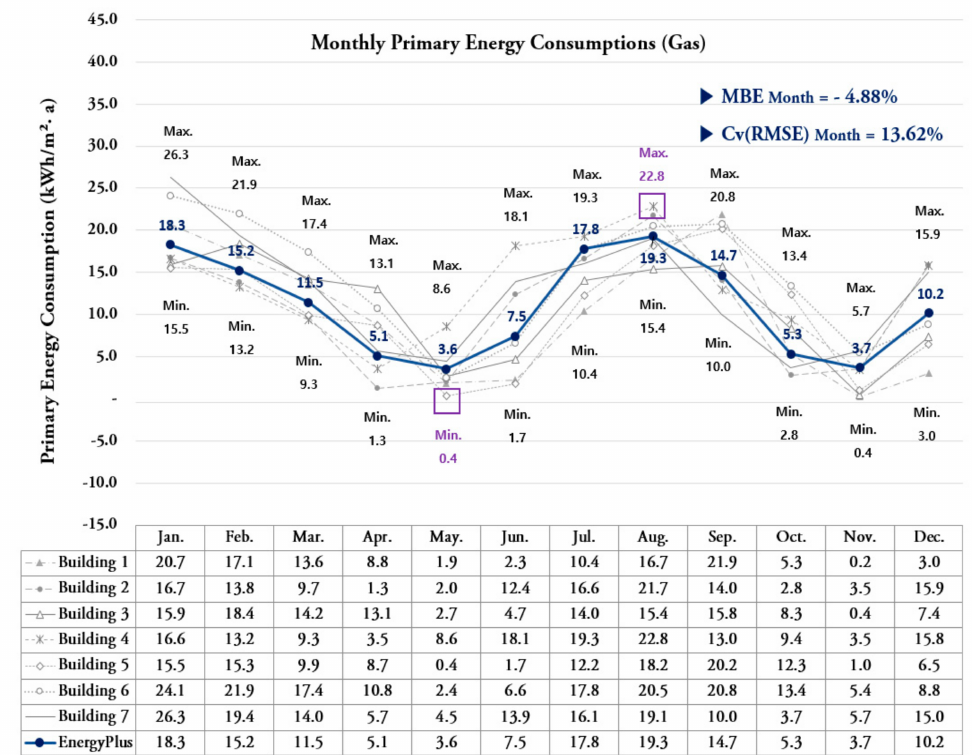
Figure 6. Comparison of gas measurement data and base model simulation